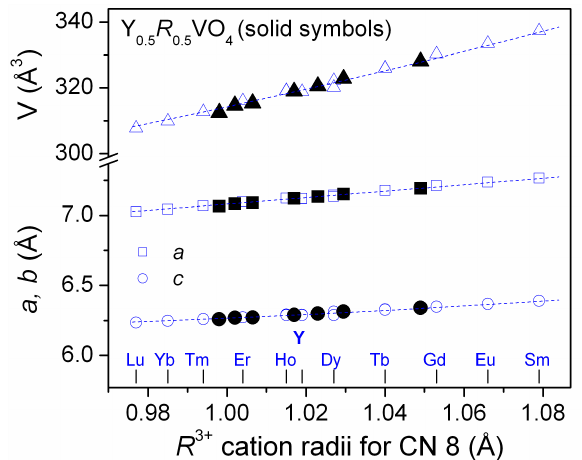
Figure 3. Lattice parameters and unit cell volumes of the Y 0.5 R 0.5 VO 4 ( R = Sm, Tb, Dy, Ho, Tm, Yb, Lu) series (solid symbols) and the parent R VO 4 compounds [13,14] (open symbols) as a function of eight-coordinated R 3+ cations after Shannon [15].